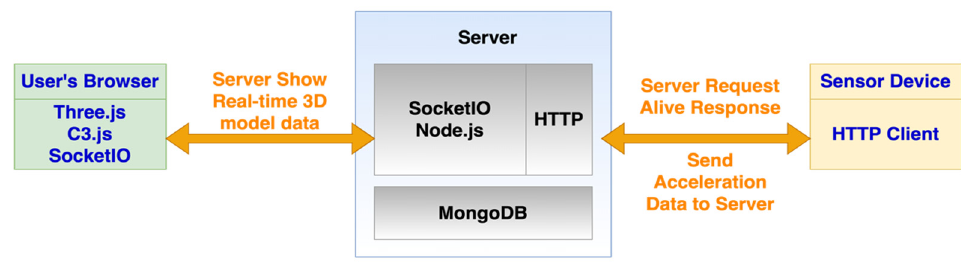
Figure 2. Architecture of the SHM system.